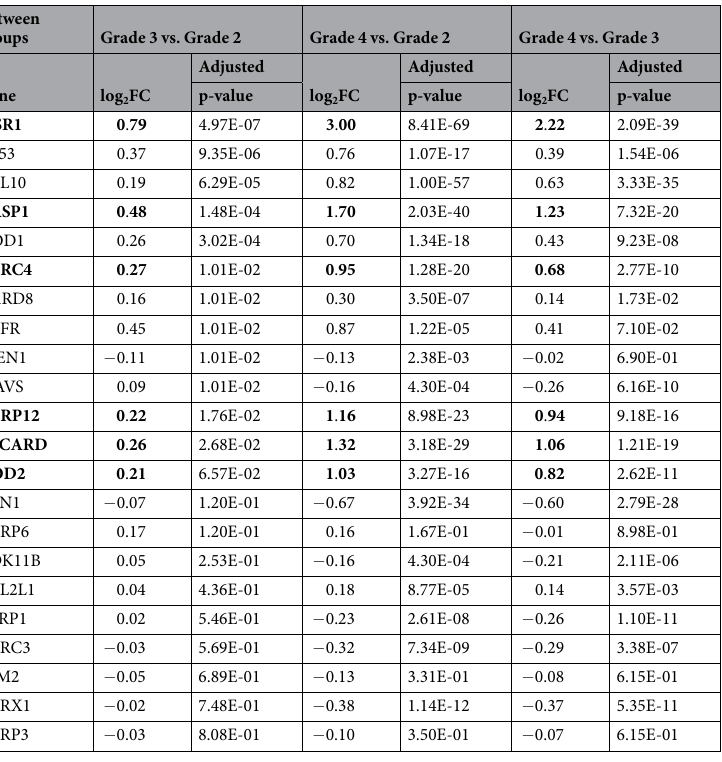
Table 1. Differential expression of NLRs and NLR-associated genes in glioma. Abbreviations: FC, fold